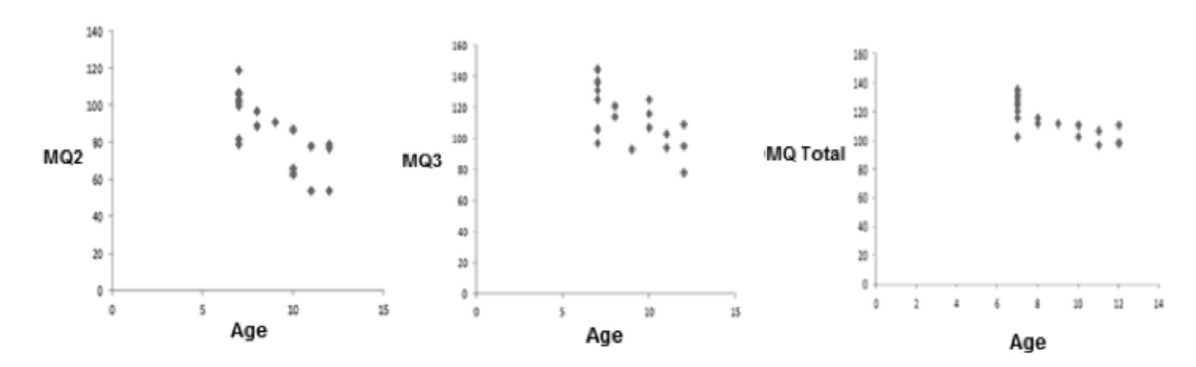
Figure 5 - Age (years) of the Experimental Group (EG) x MQ2 (Monopodal Jumping Task Motor Quotient), MQ3 (Motor Learner Task Quotient) and Total MQ (Motor Quotient Sum of motor quotients of KTK